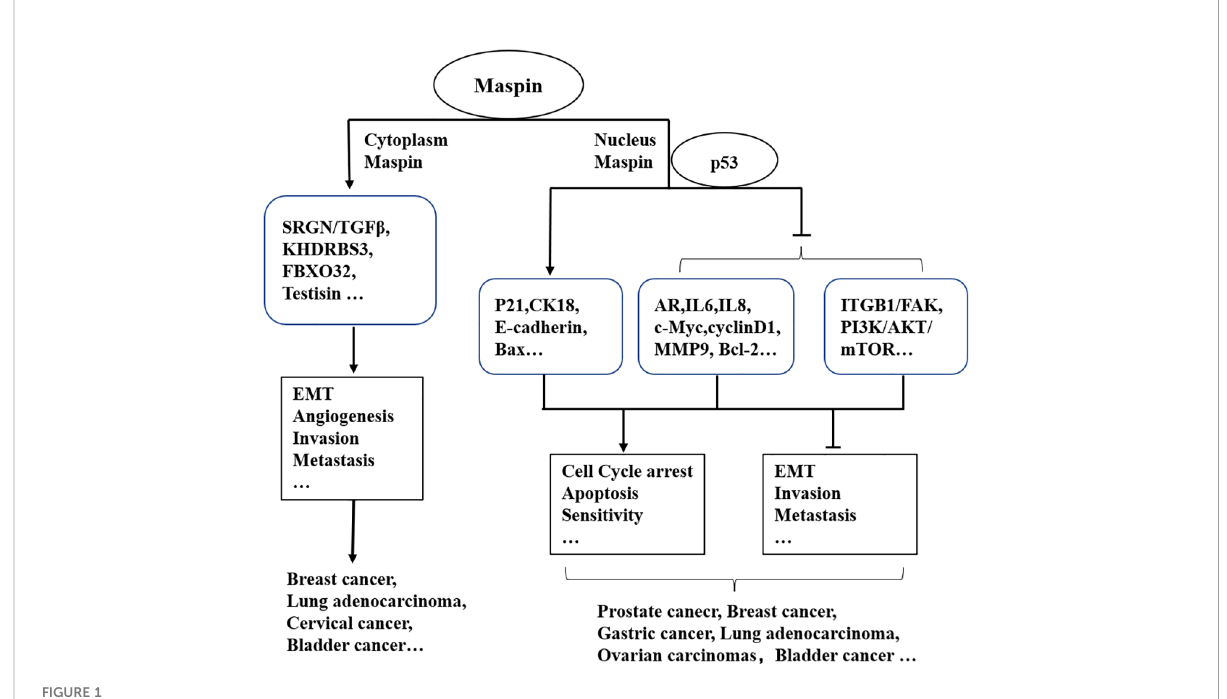
FIGURE 1 Maspin-associated signaling alteration in cellular